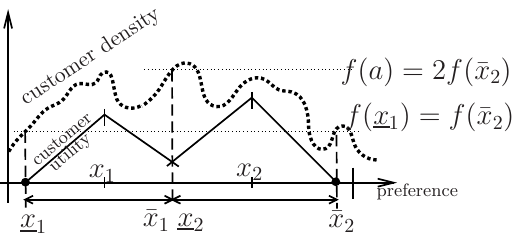
Figure 3. Differentiation strategy depending on the change rates of consumer density at the endpoints of the